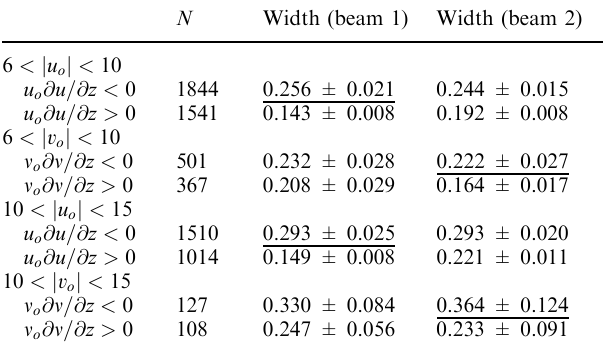
Table 2. Comparisons of the mean spectral widths at 17.1 km at WSMR when the cases are sorted according to the algebraic sign of the product of wind speed and vertical wind shear